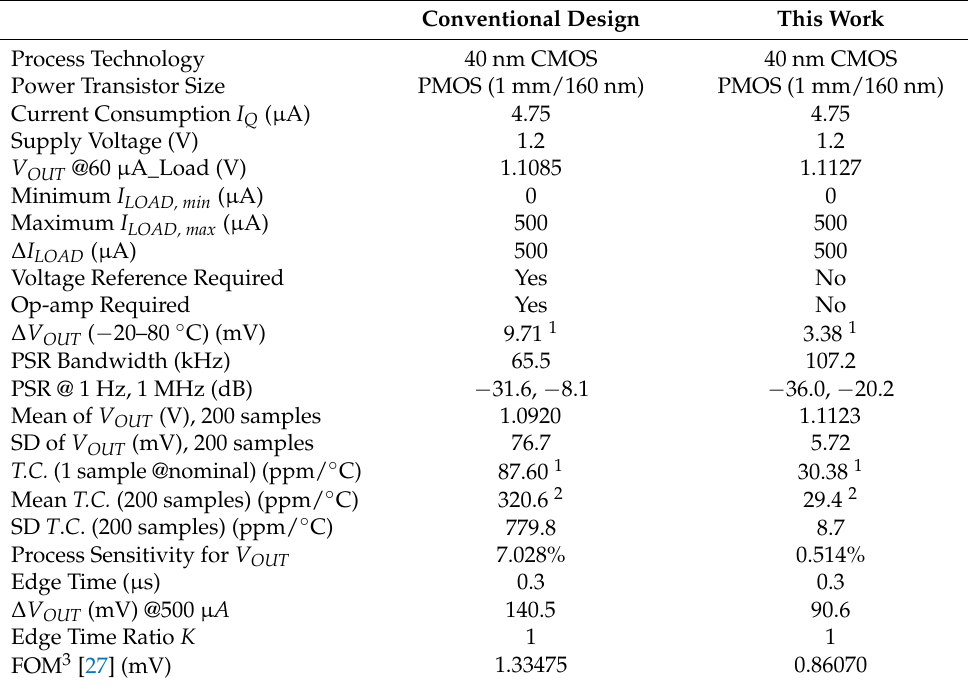
Table 6. Performance comparison of the simulation results between the conventional PSR enhancer and the Proposed Work at Typical